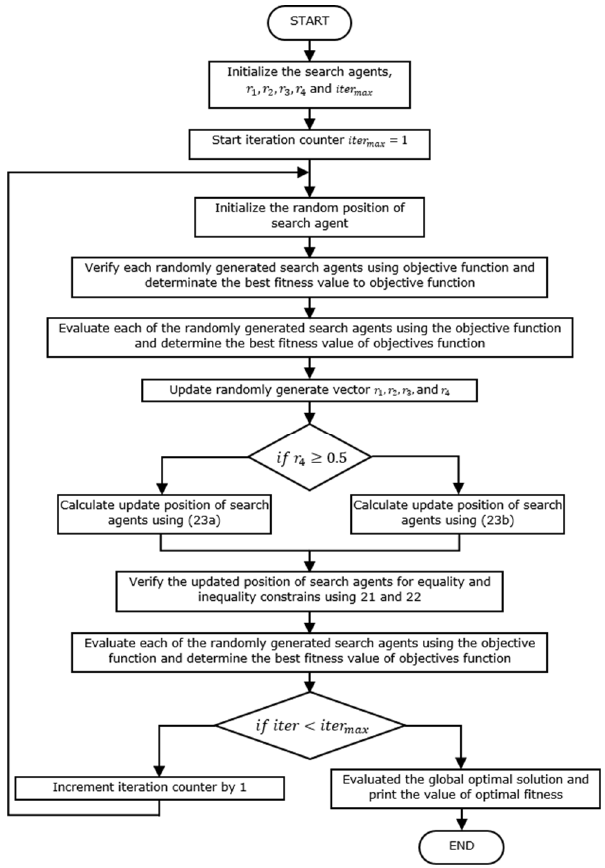
Figure 4. Sine Cosine Algorithm